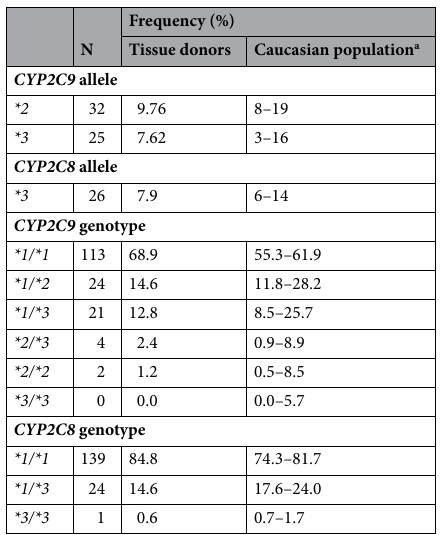
Table 2. Allele and genotype frequencies of CYP2C9*2 , CYP2C9*3 and CYP2C8*3 in liver tissue donors and in Caucasian population. a Allele frequencies in Caucasian population according to Zanger and Schwab 6 , Genotype frequencies in Caucasian population according to Zhou et al. 5 , Yasar et al. 32 , Dai et al. 71 , Takahashi and Echizen 72 , Scordo et al. 73